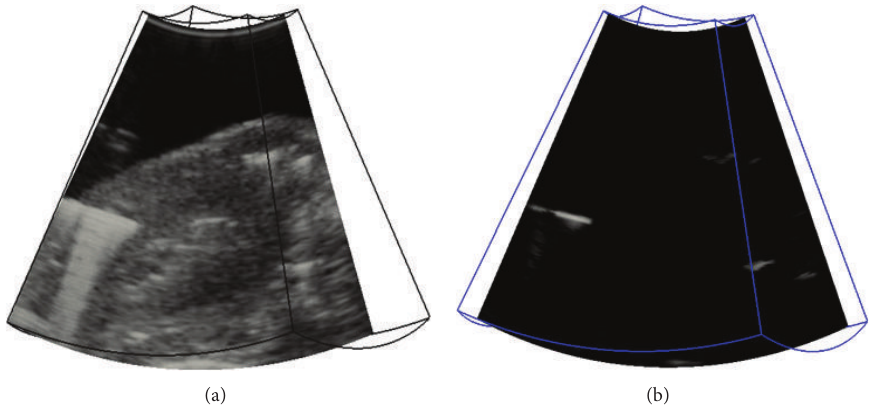
Figure 1: The original 3D US volume (a) and its tubularness volume (b).